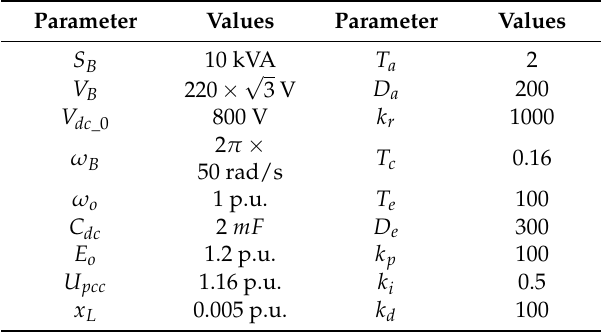
Table 1. Parameters of virtual inertia frequency control (VIFC)-based photovoltaic (PV) system.